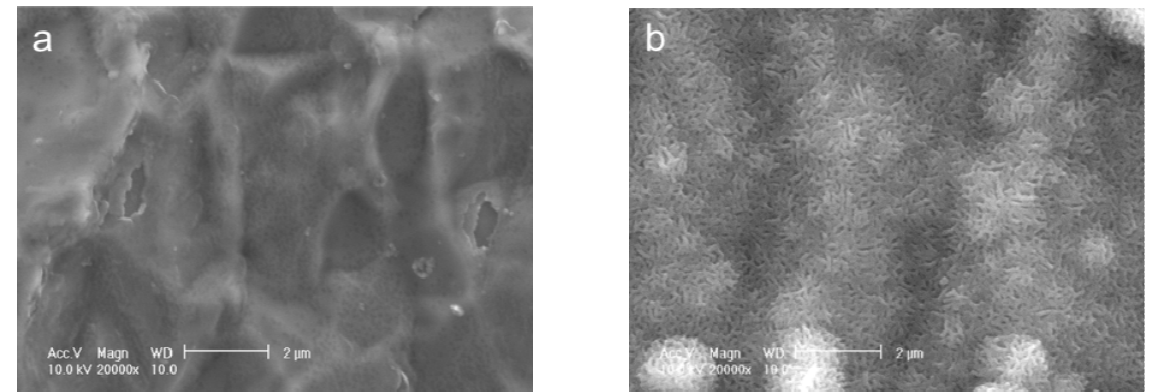
Figure 1. SEM images of the surfaces of Ti pins before ( a ) and after ( b ) immersion in the CaP solution at 25 °C for 24 h.